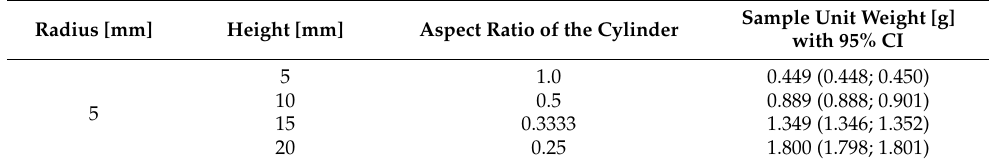
Table 2. Dimensions of the tested samples.